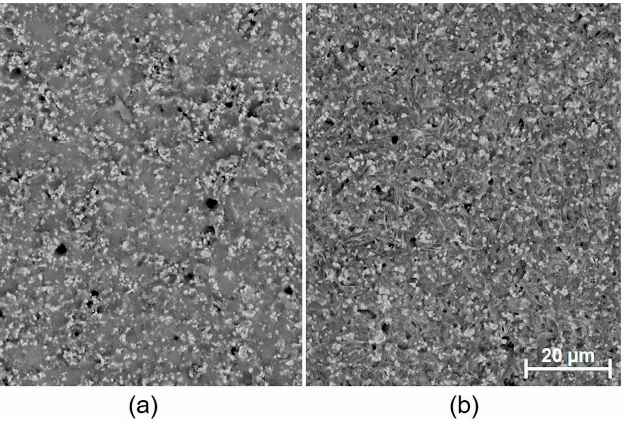
Figure 10. SEM image of the surface of fired paste 5704: ( a ) 1 layer and 1 firing (specimen group 4); ( b ) 1 layer and 1 firing, followed by a two-hour annealing (850 °C).